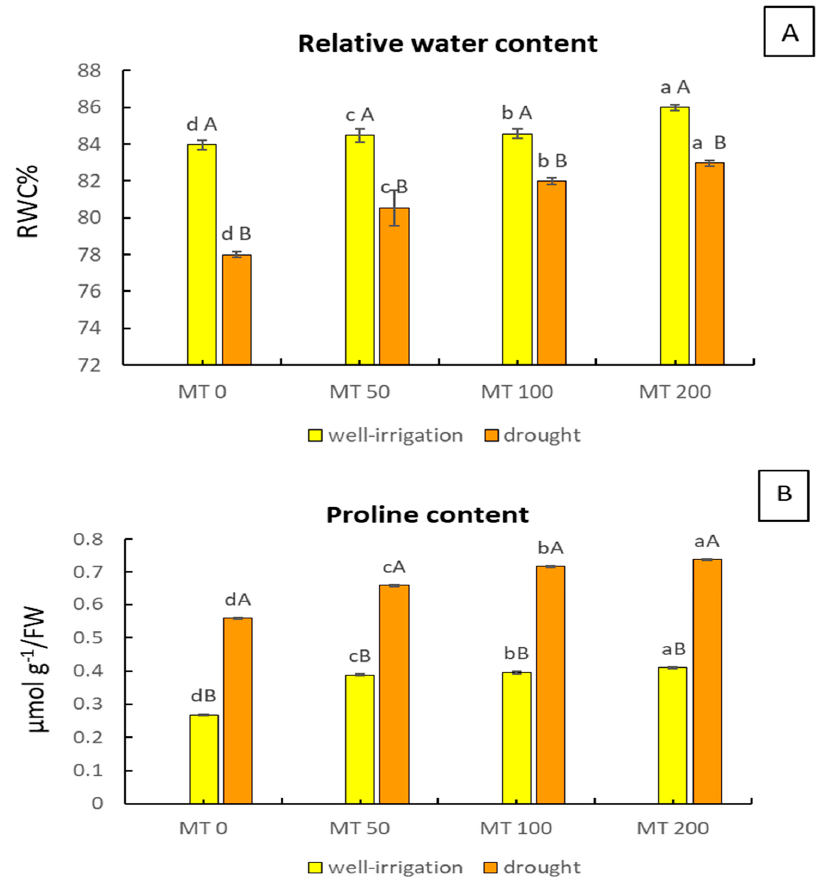
Figure 4. Effect of exogenous melatonin on the relative water content (%) ( A ) and proline content ( μ mol g − 1 /FW) ( B ) of R. asiaticus under drought stress conditions. Lowercase letters: comparison of MT concentrations under fixed irrigation treatments; uppercase letters: comparison of the irrigation treatment groups under fixed MT concentration levels (Tukey/Games-Howell test, p <